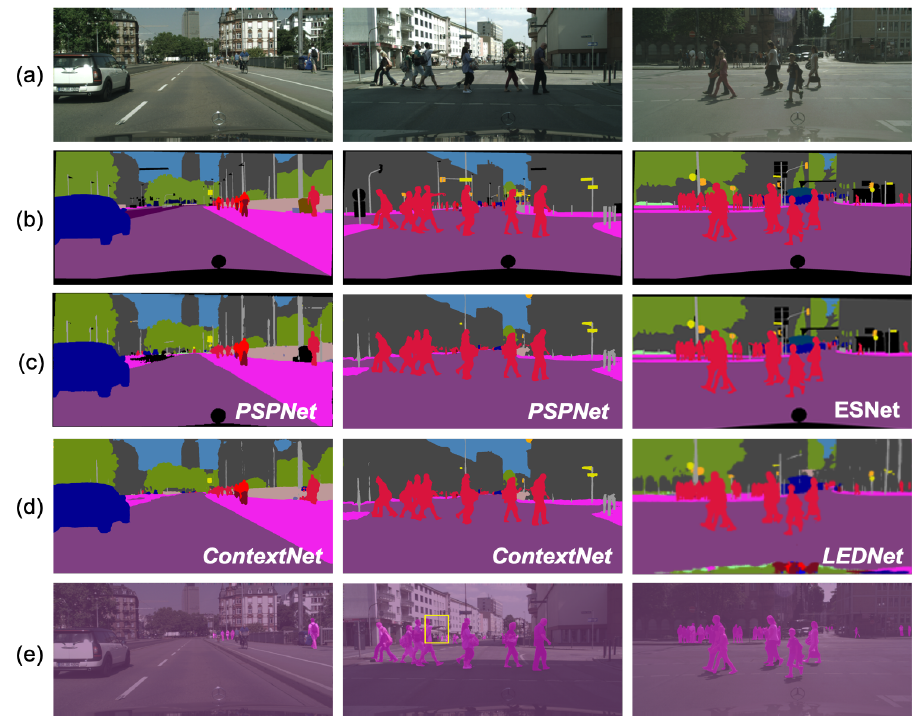
Figure 5. Visual results in the Cityscapes validation set [12] were compared with segmentation results for